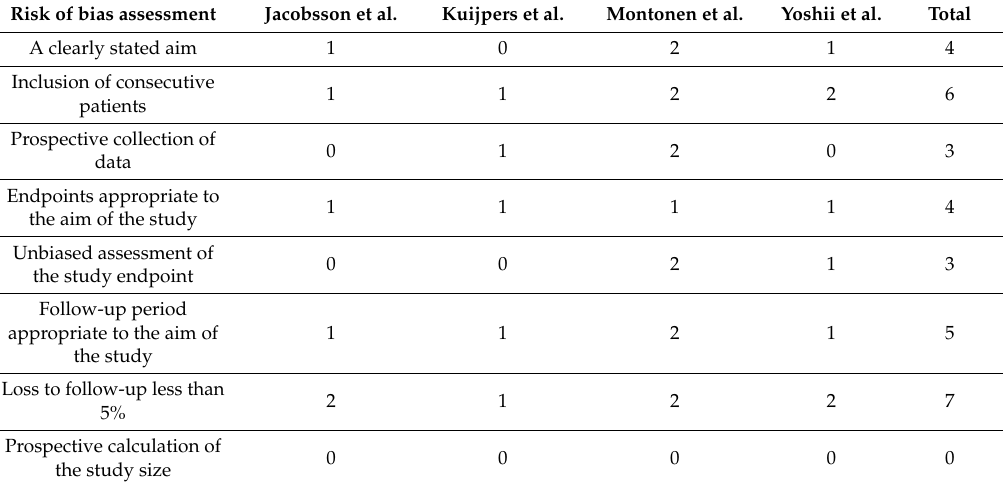
Table 4. Risk of bias within studies MINORS